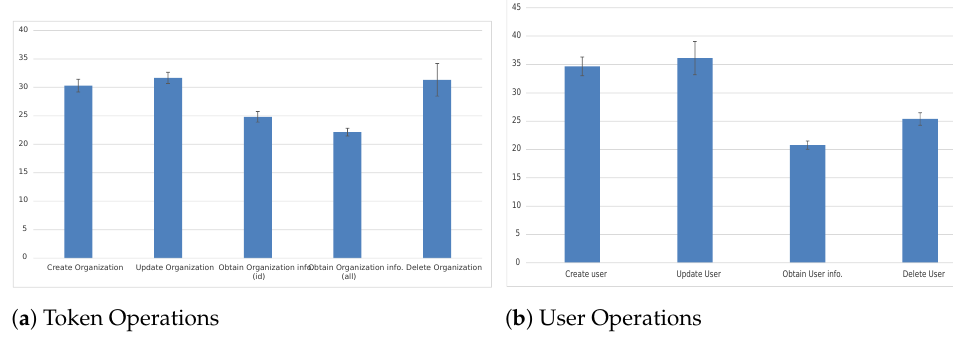
Figure 13. Delay of Identity Management Operations (units in milliseconds).